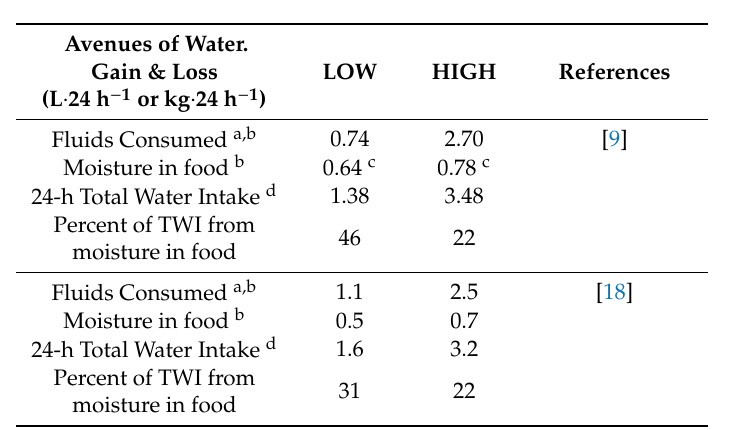
Table 4. Dietary water sources of habitual low volume (LOW) and high volume (HIGH) drinkers in two investigations.